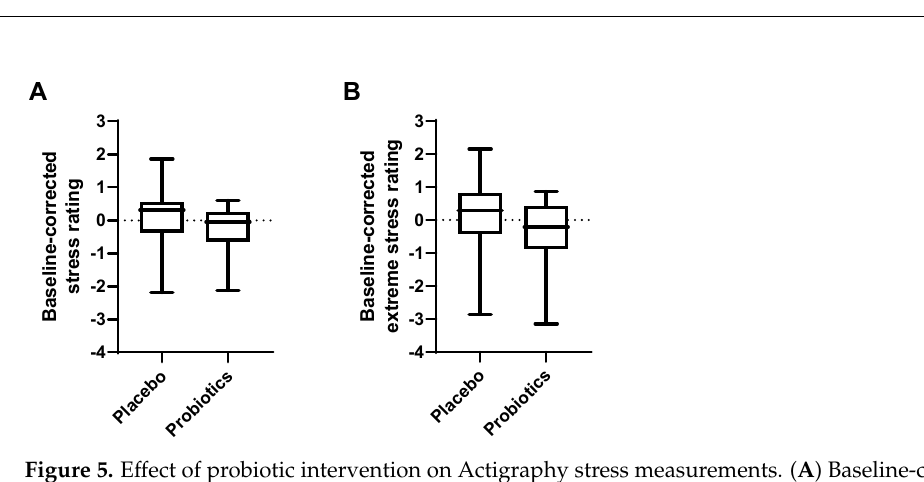
Figure 5. Effect of probiotic intervention on Actigraphy stress measurements. ( A ) Baseline-corrected average of daily stress ratings and ( B ) extreme daily stress ratings. Line presents median, box pre- sents 25th and 75th percentile, whiskers present minimum and maximum.